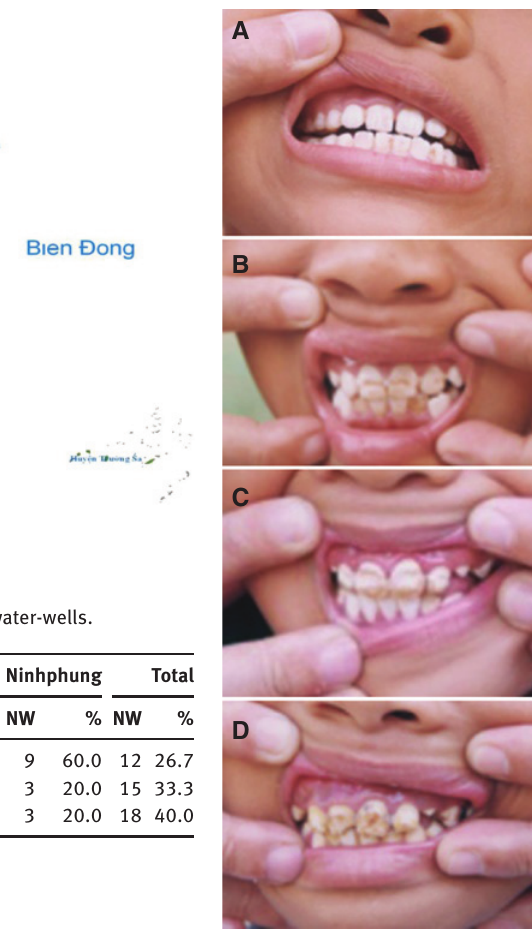
Table 7: Dental fluorosis assessed by Dean’s index and CFI in surveyed area.